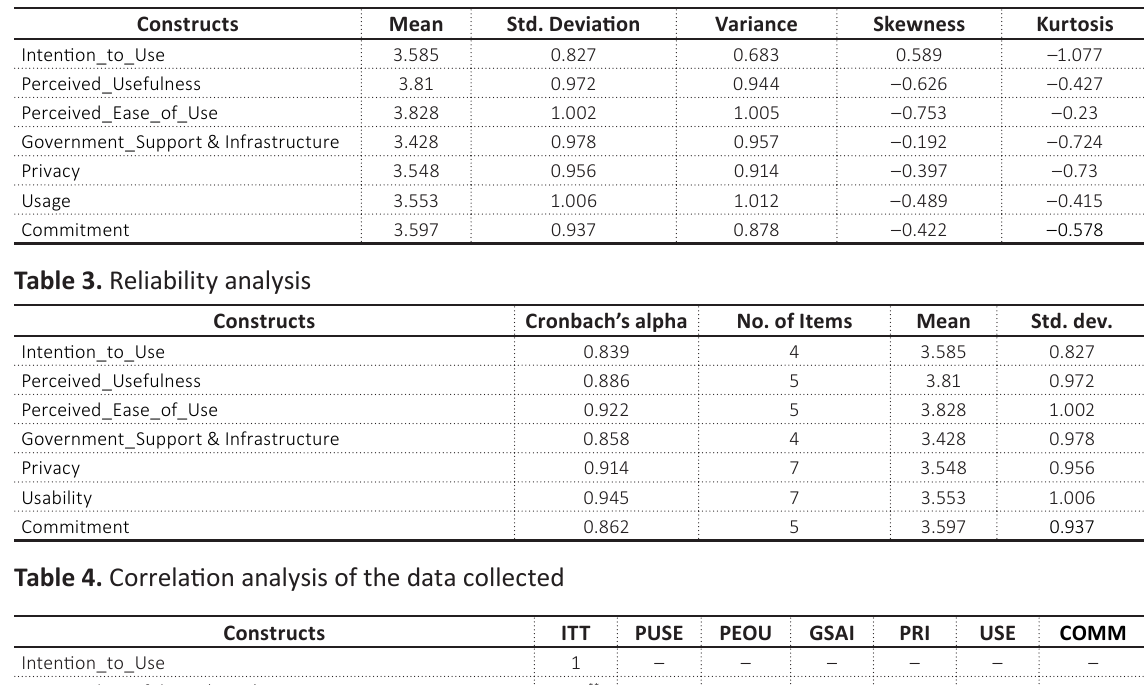
Table 2. Descriptive statistics